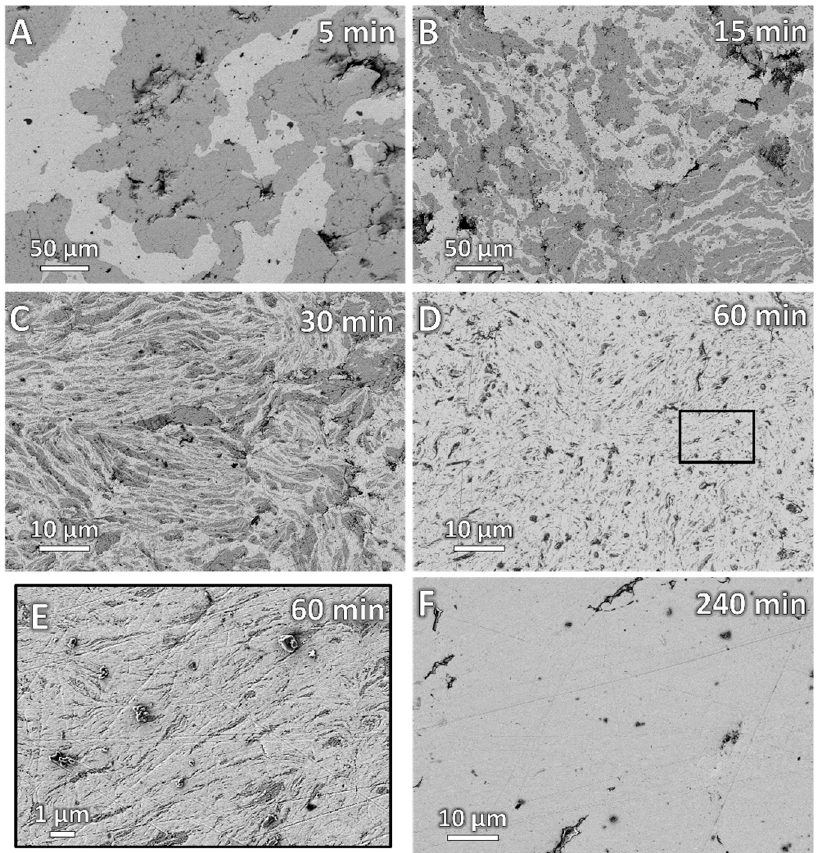
Figure 2. SEM micrographs of polished sections of alloys after milling for ( A ) 5 min, ( B ) 15 min, ( C ) 30 min, ( D ) 60 min, with ( E ) high-magnification image of inset, and ( F ) 240 min. Darker regions of images are Co and lighter regions are Pd. No distinct regions are visible after 240